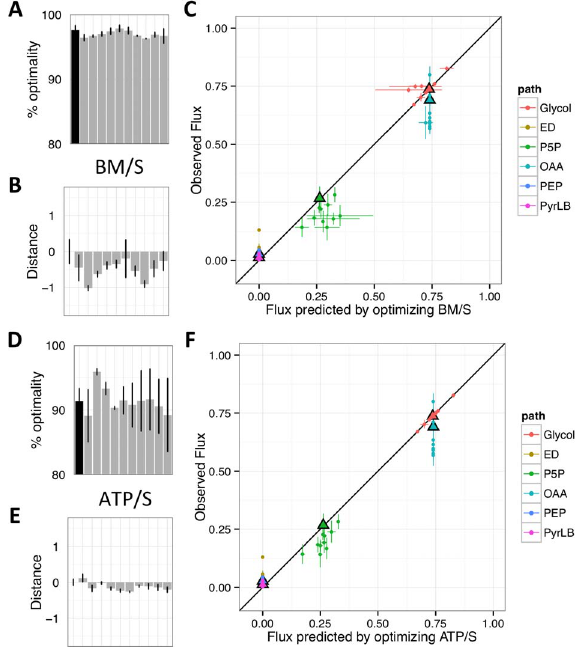
Figure 3. Measures of optimality and predictability after adaptation of LTEE populations to glucose for 50,000 gener- ations. A,D) The % optimality of the ancestor (black) and evolved isolates (grey, same order as Fig. 2); B,E) distance to optimal flux distribution (plotted as log(D EO /D AO )); and C, F) comparison of predicted to observed flux ratios for FBA-predictions based upon BM/ S (A–C) or ATP/S (D–F). Error bars represent standard errors of three biological